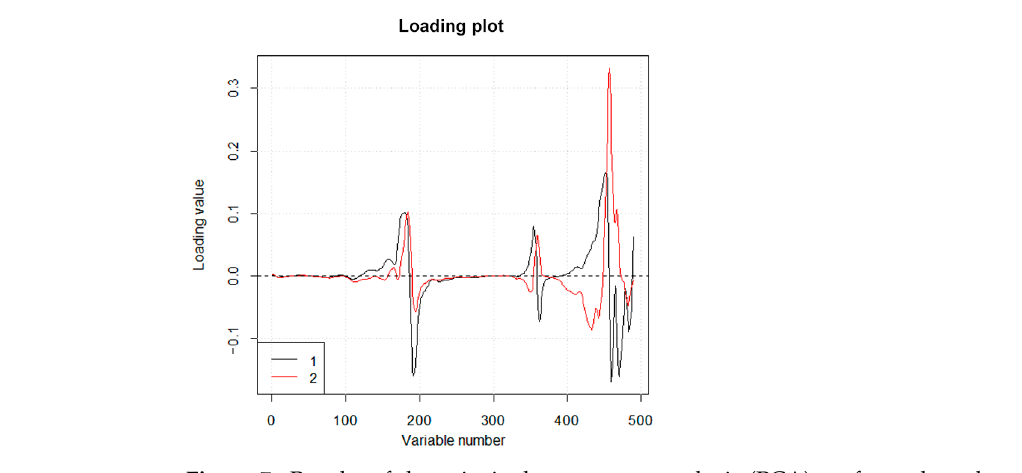
Figure 7. Results of the principal component analysis (PCA) performed on the reflection FT-IR spectral dataset in the range 1400–400 cm − 1 : loading plot of PC1 and